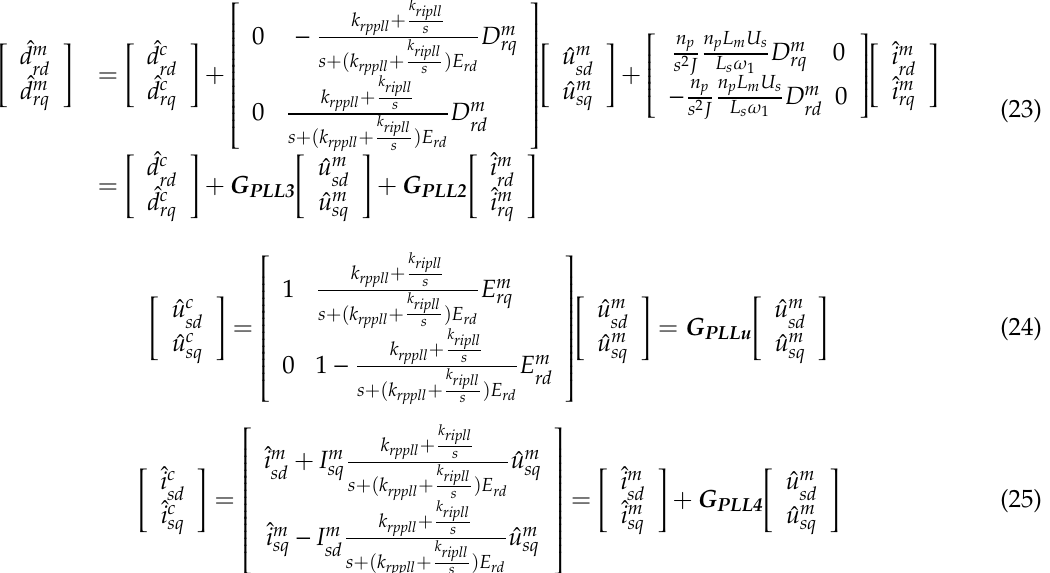
Figure 8. The small-signal transfer diagram of PLL in the RSC control. This PLL model links the variables from the circuit module to the control module.